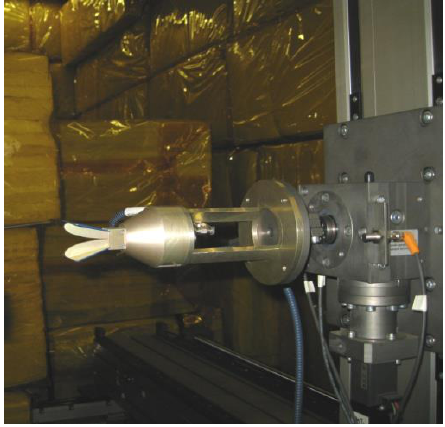
Fig. 2. Antenna SH 4000 on the